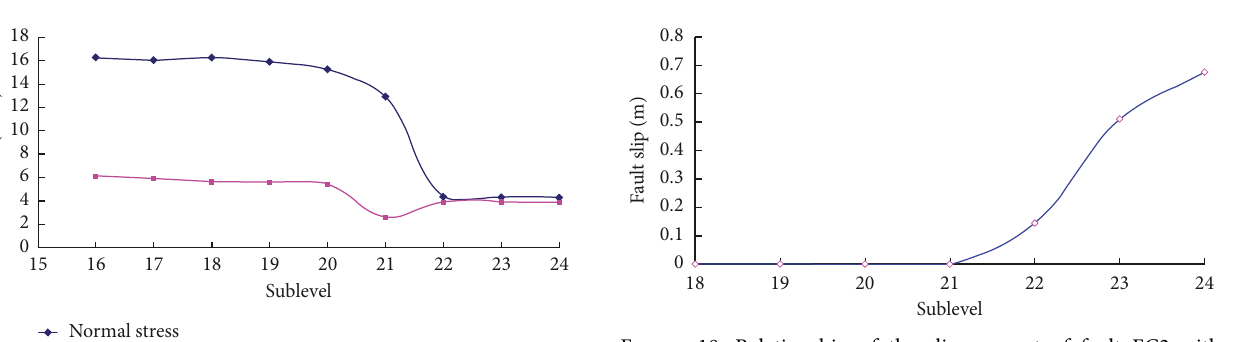
Figure 18: Relationship of the slip amount of fault FC2 with mining depth.